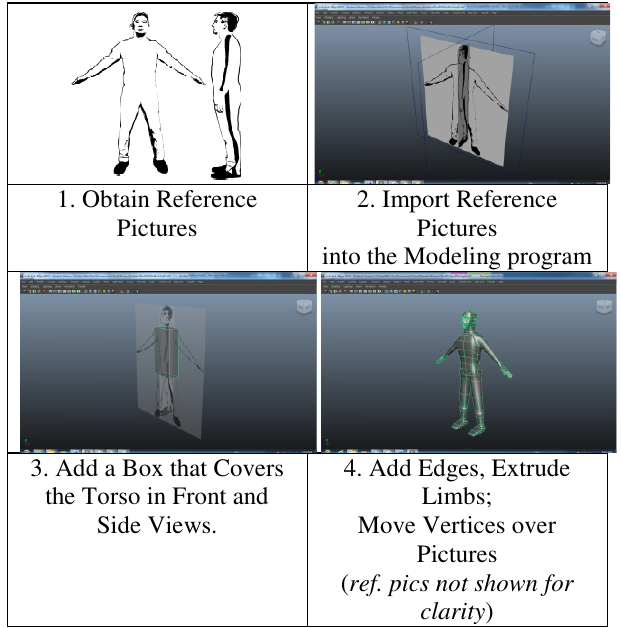
Figure 2. 3-D Tracing: A Modeler (1) Takes front and side pictures of a human figure; (2) Imports them into a 3-D modeling program; (3) Adds a basic box that covers the torso; (4) Mold the box to the